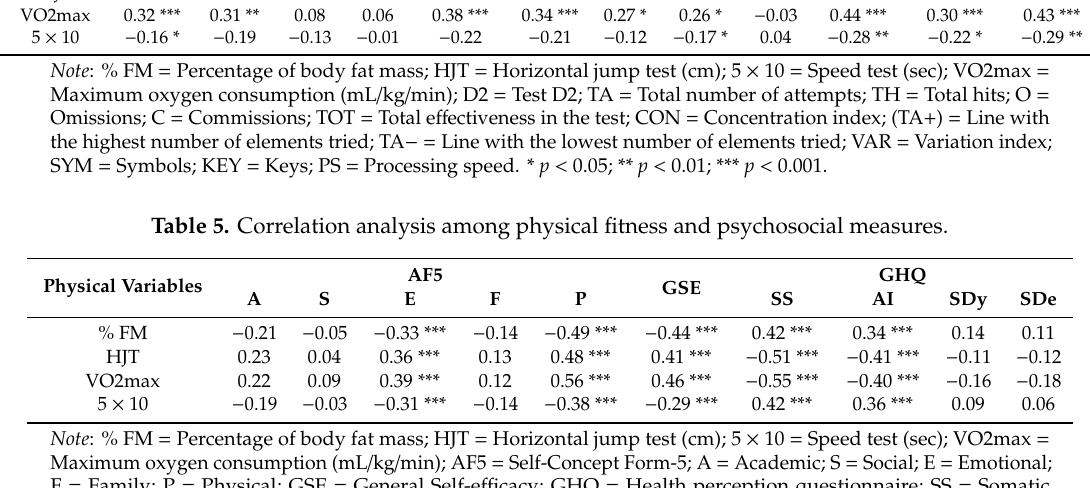
Table 4. Correlation analysis among physical fitness and cognitive functioning measures. Physical Variables